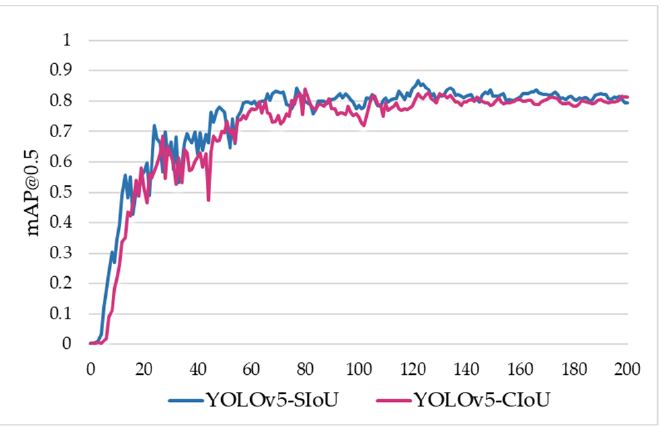
Figure 3. Comparison of the training effect of SIoU and CIoU based on YOLOv5 model.